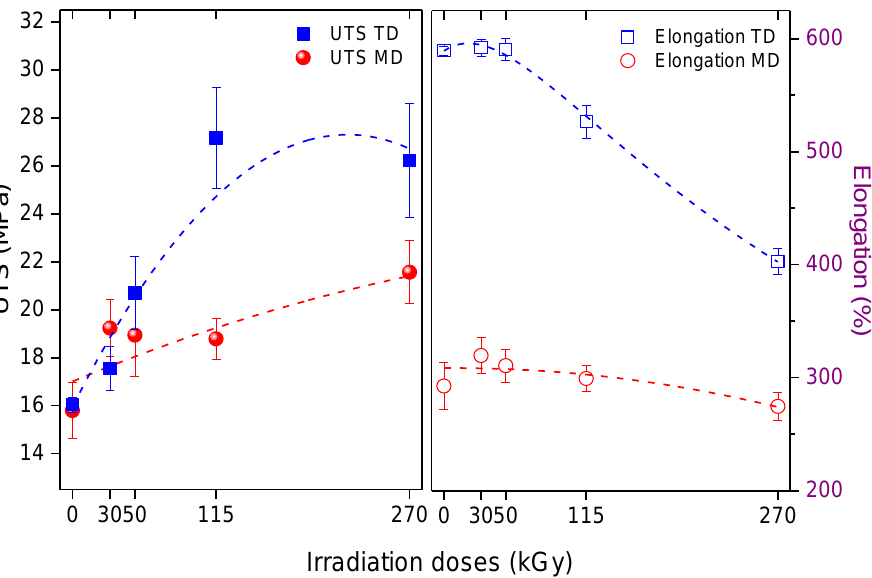
Figure 6. (Left) Ultimate Tensile Strength (UTS) for TD (blue solid squares) and MD (red solid circles), and (right) elongation for TD (blue open squares) and MD (red open circles) as a function of the γ-irradiation dose. Dashed fitting curves are prearranged. Reproduced from [34] with the permission of Journal of Applied Polymer Science.